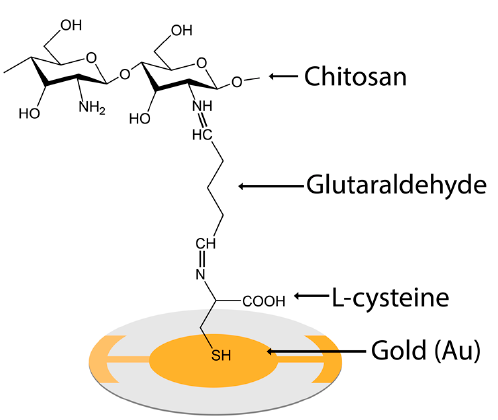
Figure 1. Schematic chemical structure and active layer deposition of the chitosan-based QCM chip for alcohol sensing.